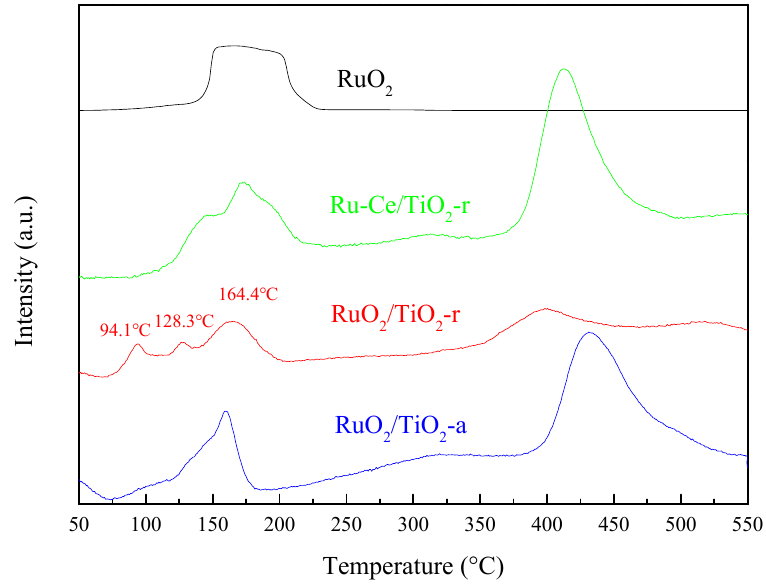
Figure 5. H 2 -TPR profiles of the bulk and supported RuO 2 catalysts.